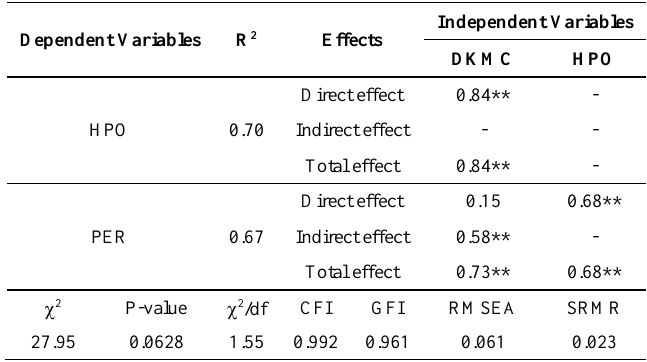
Table 4. Direct and indirect effects of the structural model